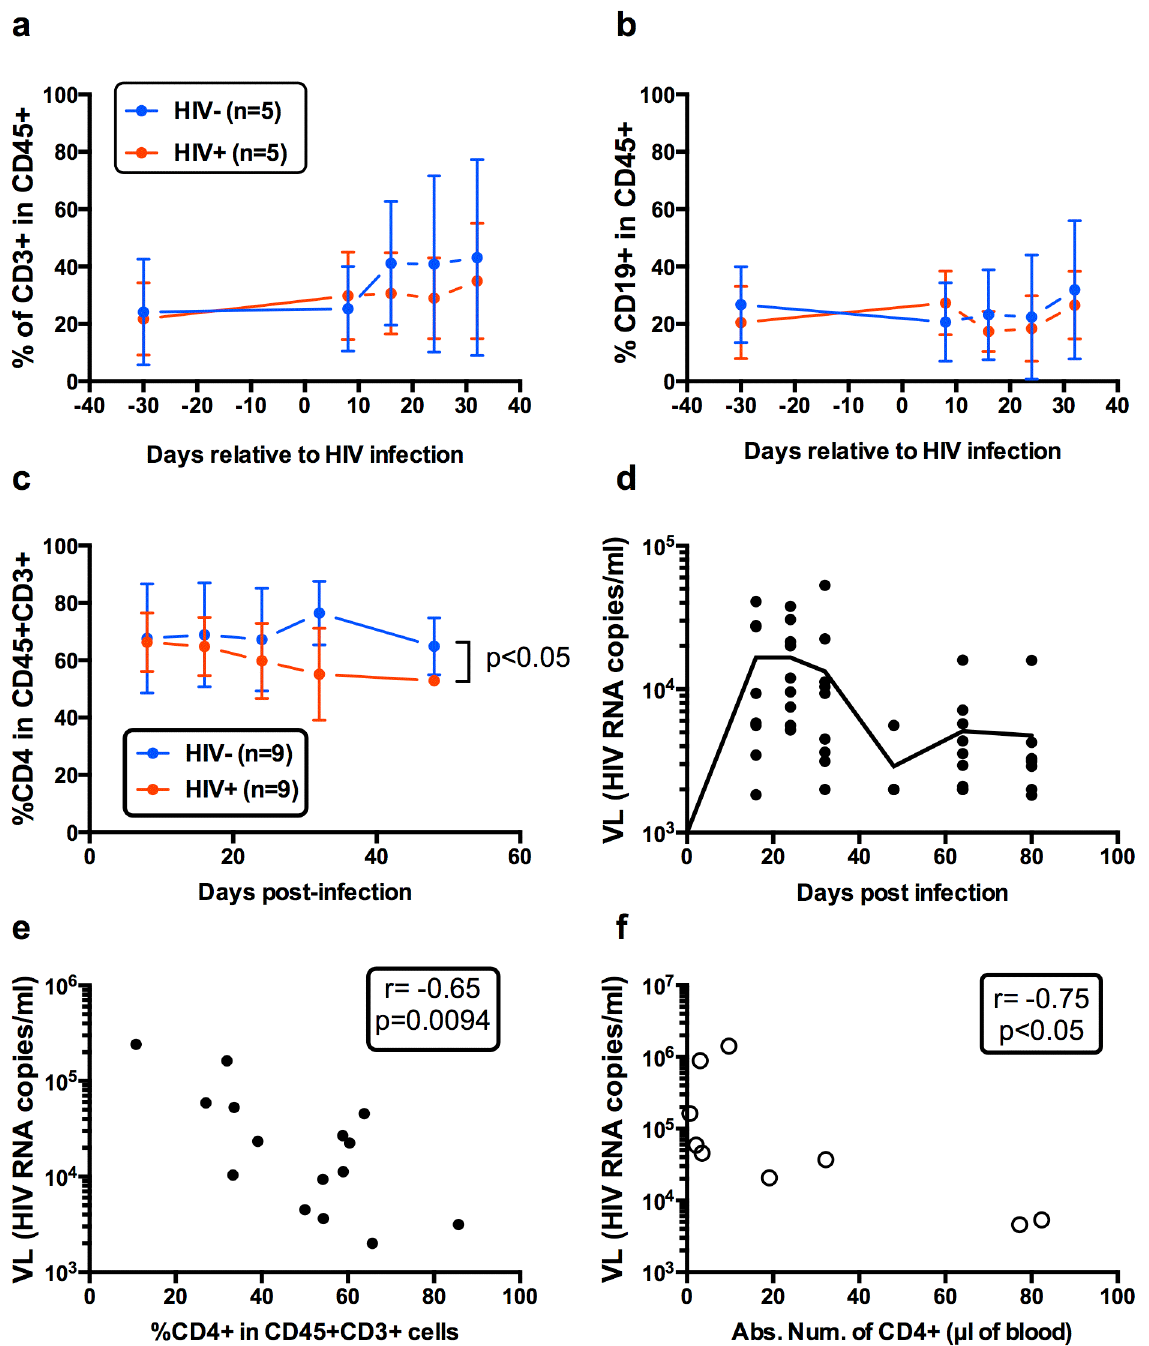
Fig 1. Early features of HIV infection in the blood of NSG HuMice. Frequencies of CD3 + T cells (a) and CD19 + B cells (b) in CD45 + humans cells from the blood of NSG HuMice infected at 19 weeks of age (D0 on the graph) (c) Frequencies of CD4 + T cells in CD45 + CD3 + human cells in the blood relative to the day of infection. The p value is from a linear regression analysis. (d) Viral loads (VL) in the blood of HIV-infected NSG HuMice was determined by the Cobas PCR at the time indicated in the legend. Results shown in c and d are from 2 independent experiments. (e) Correlation between viral loads (VL) and frequency of CD4 + T cells at 30 days post-infection with 10 to 50 ng p24 of CCR5-tropic HIV. Results shown are cumulative from 4 independent experiments with HuMice aged from 19 to 28 weeks of age when infected. Each dot represents a single mouse. (f) Correlation between viral loads (VL) and absolute numbers of CD4 + T cells in the blood of HuMice infected with 50 ng p24 of CCR5-tropic HIV at 25 weeks of age. Results represent cumulative values obtained at 14 and 37 days post infection from a total of 5 mice analyzed in a single experiment. The non-parametric Spearman correlation coefficient and the p value are indicated in panels e and f.